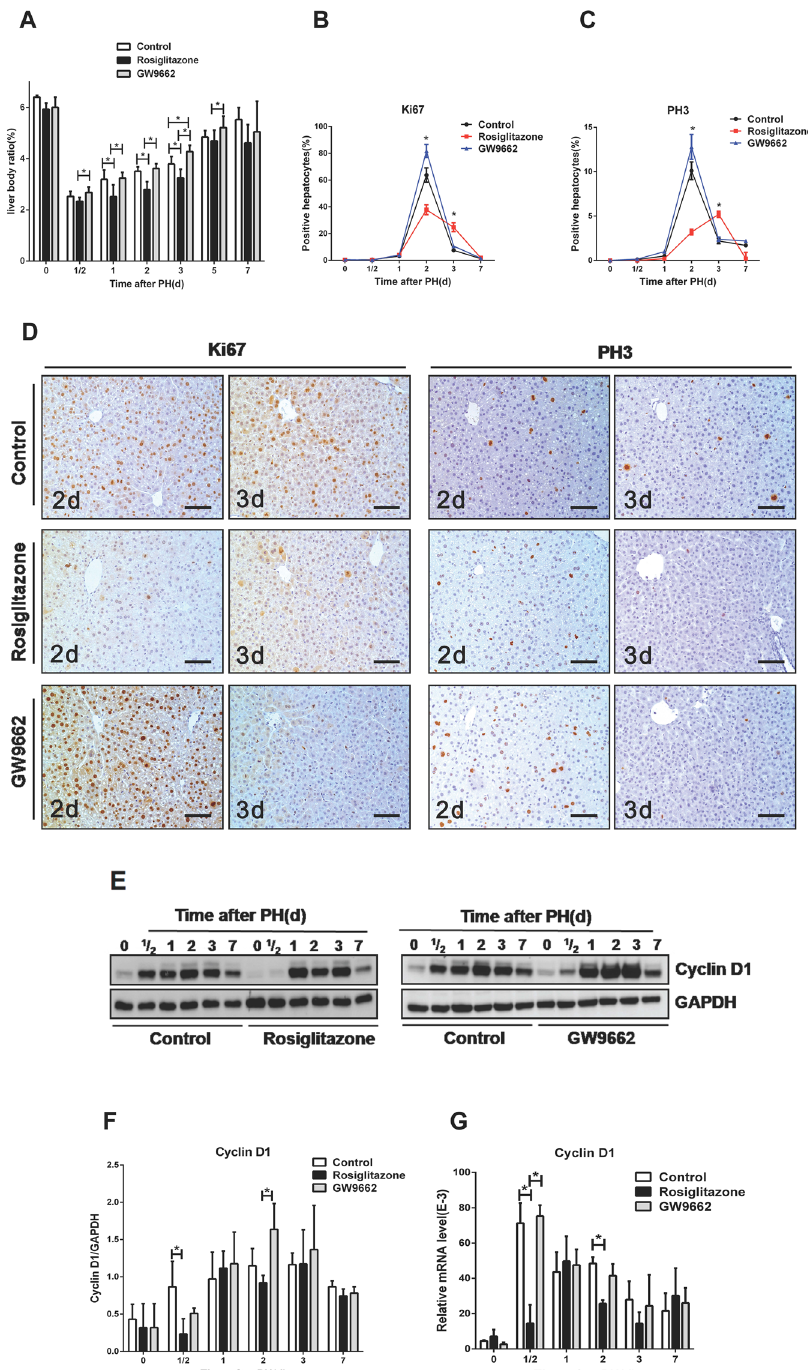
Figure 2. Ligand activation of PPAR γ inhibits mouse liver regeneration after PH. ( A ) Liver to body weight ratio in untreated mice, rosiglitazone-treated mice, and GW9662-treated mice at different time points after PH. ( B ) Quantification of Ki67-positive hepatocytes and ( C ) PH3-positive hepatocytes. ( D ) Micrographs of liver sections immunostained with Ki67 & PH3 antibody from untreated, rosiglitazone- and GW9662-treated mice after PH. Scale bar: 200 μ m. ( E ) Assessment of Cyclin D1 protein expression in the regenerating liver. Left panel: Western blot analysis of Cyclin D1 in untreated mice vs. rosiglitazone-treated mice. Right panel: Untreated mice vs. GW9662-treated mice. ( F ) Quantification of Western blot analysis for Cyclin D1 expression after analysis of three biological triplicates. ( G ) Real-time PCR analysis of Cyclin D1 mRNA expression after PH in untreated, rosiglitazone-treated, and GW9662-treated groups. * p <